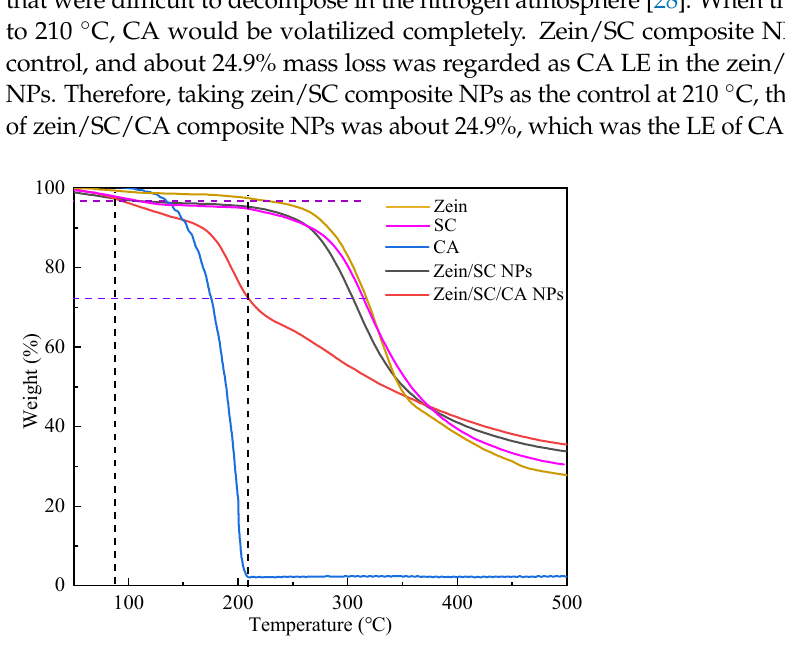
Figure 7. TGA pattern of zein, SC, CA, zein/SC composite NPs, and zein/SC/CA composite NPs.